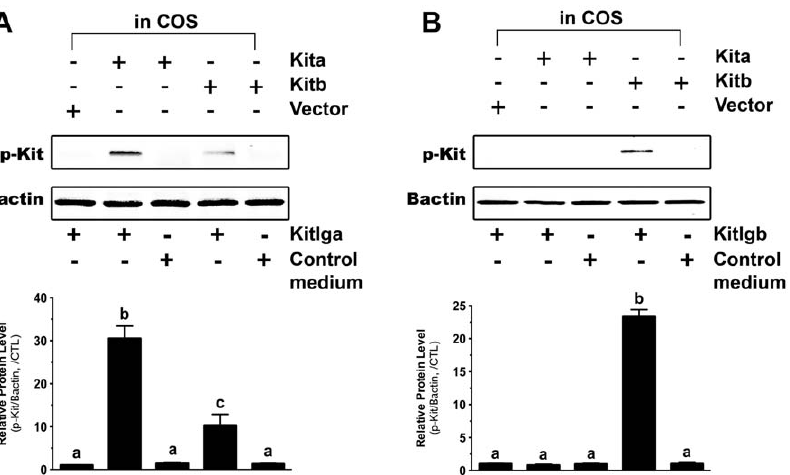
Figure 4. Response of zebrafish Kita and Kitb to zebrafish Kitlga and Kitlgb. The COS-1 cells expressing Kita and Kitb were treated with conditioned media containing recombinant Kitlga (A) and Kitlgb (B) for 10 min followed by Western blot analysis for Kit phosphorylation. The control medium was from the CHO cells carrying the control plasmid pcDNA5/FRT. The expression plasmid pCMV-Script (Vector) was used as the control in the COS-1 cells. The densitometric analysis of the Western signals is shown at the bottom of each graph. The data were normalized to Bactin and expressed as the fold change compared to the first group (mean 6 SEM, n=3). Different letters indicate statistical significance ( P , 0.05). p-Kit, Kit phosphorylation; + , recombinant ligand proteins were added or cells were transfected with specific receptor plasmids; 2 , no recombinant ligands or